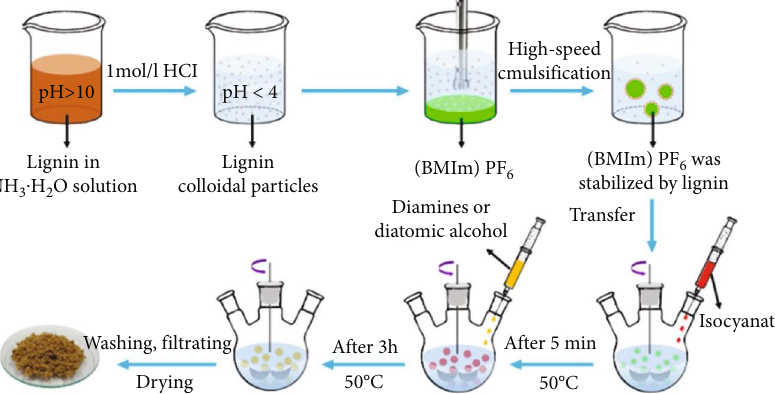
Figure 55: Synthetic process of PU microcapsules by the interfacial polymerization in lignin stabilized Pickering emulsion [150]. Table 2: Mean diameter of [BMIm]PF6@PU microcapsules obtained with di ff erent emulsi fi cation rate and with di ff erent lignin content, adapted from [150]. Sample Lignin content